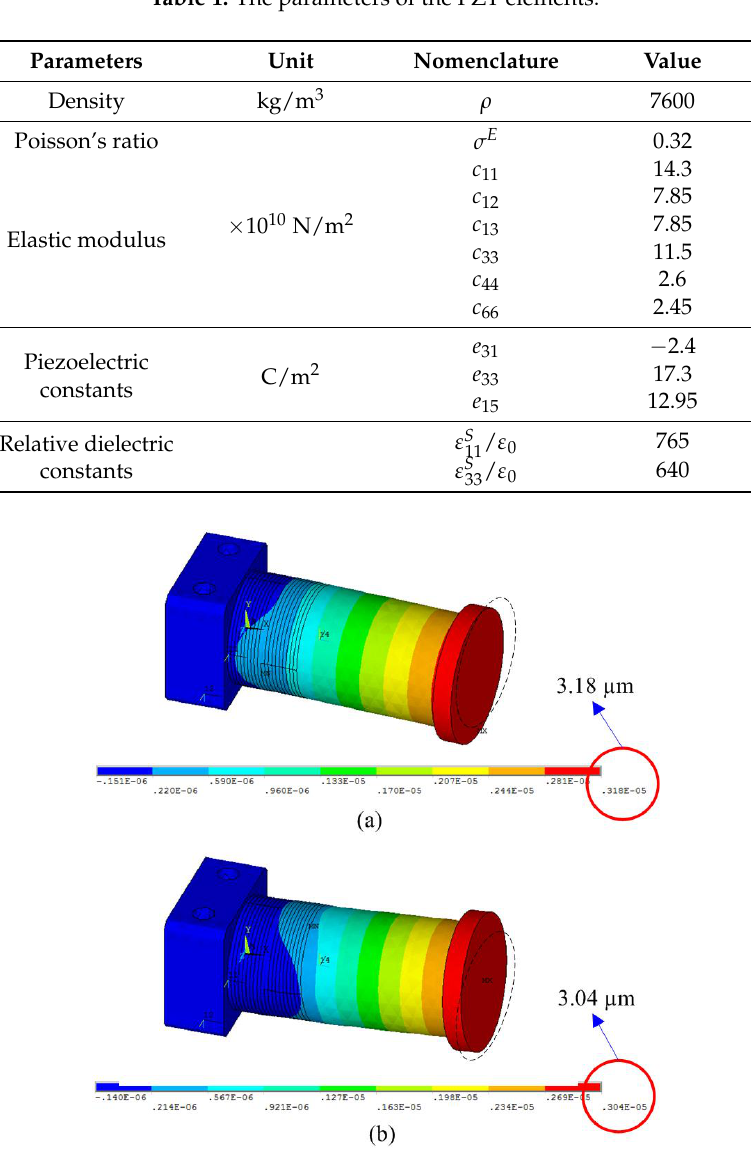
Figure 4. The static analysis results. ( a ) Horizontal bending deformation. ( b ) Vertical bending deformation.